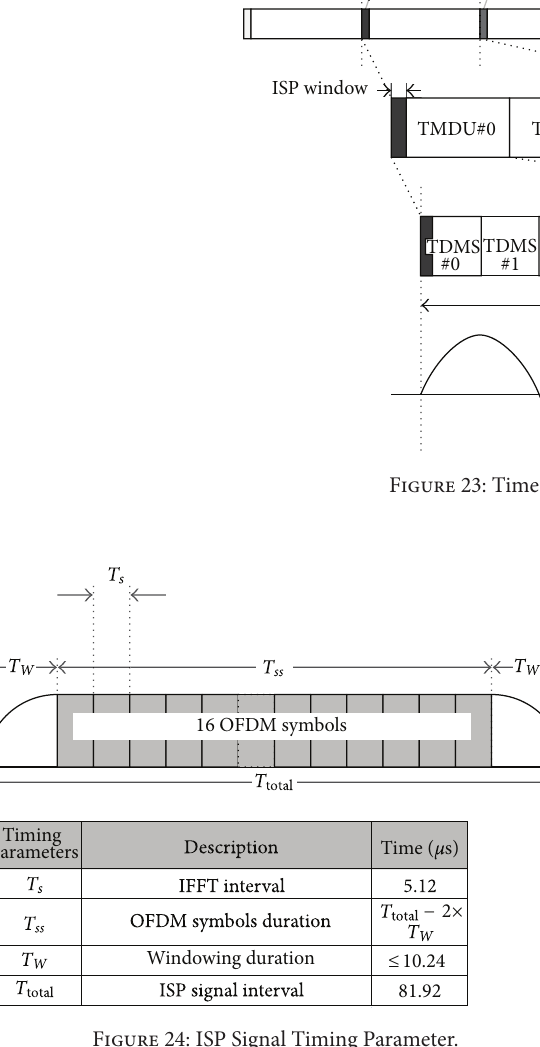
Figure 24: ISP Signal Timing Parameter.